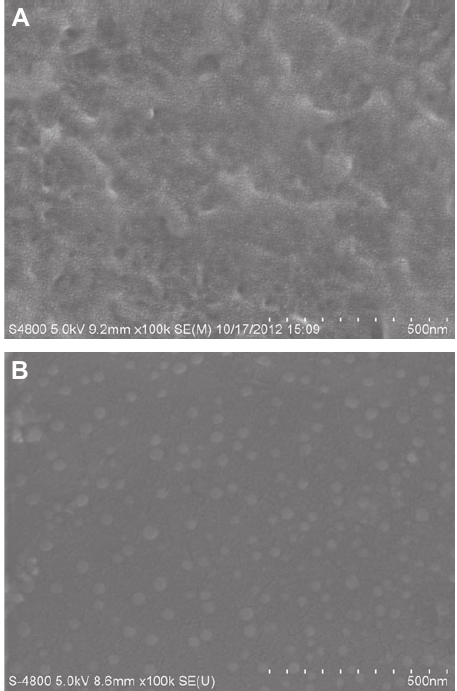
Figure 4 SEM images of freeze-fracture surfaces of neat PS (A) and PS-OV-POSS composite containing 2 wt% OV-POSS